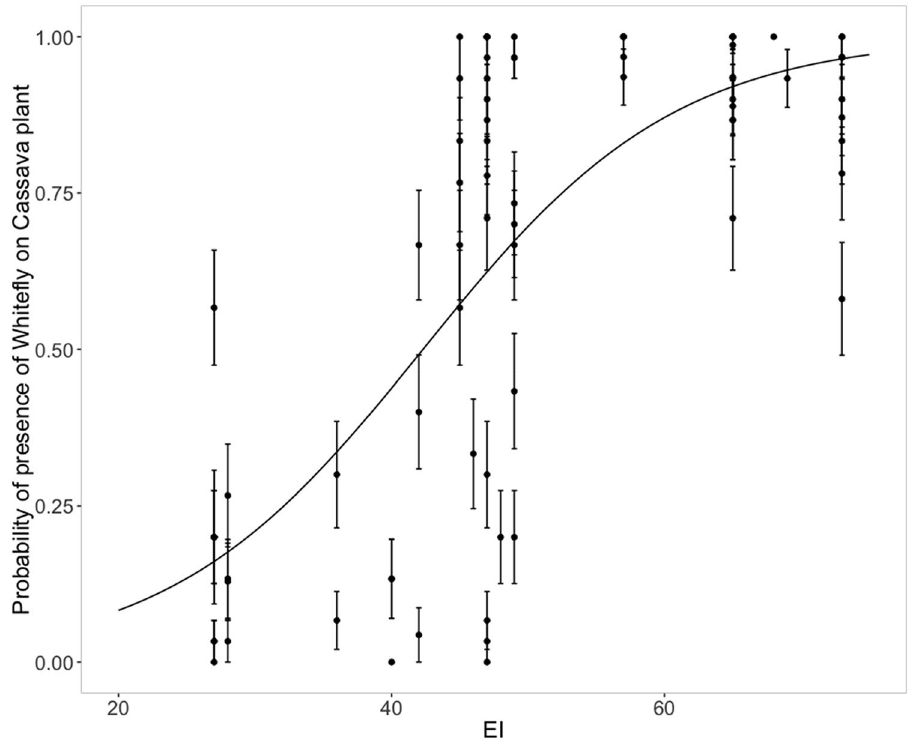
Figure 5. Probability of adult Bemisia tabaci (species not determined) presence on a cassava plant as a function of CLIMEX Ecoclimatic Index (EI) for Bemisia tabaci